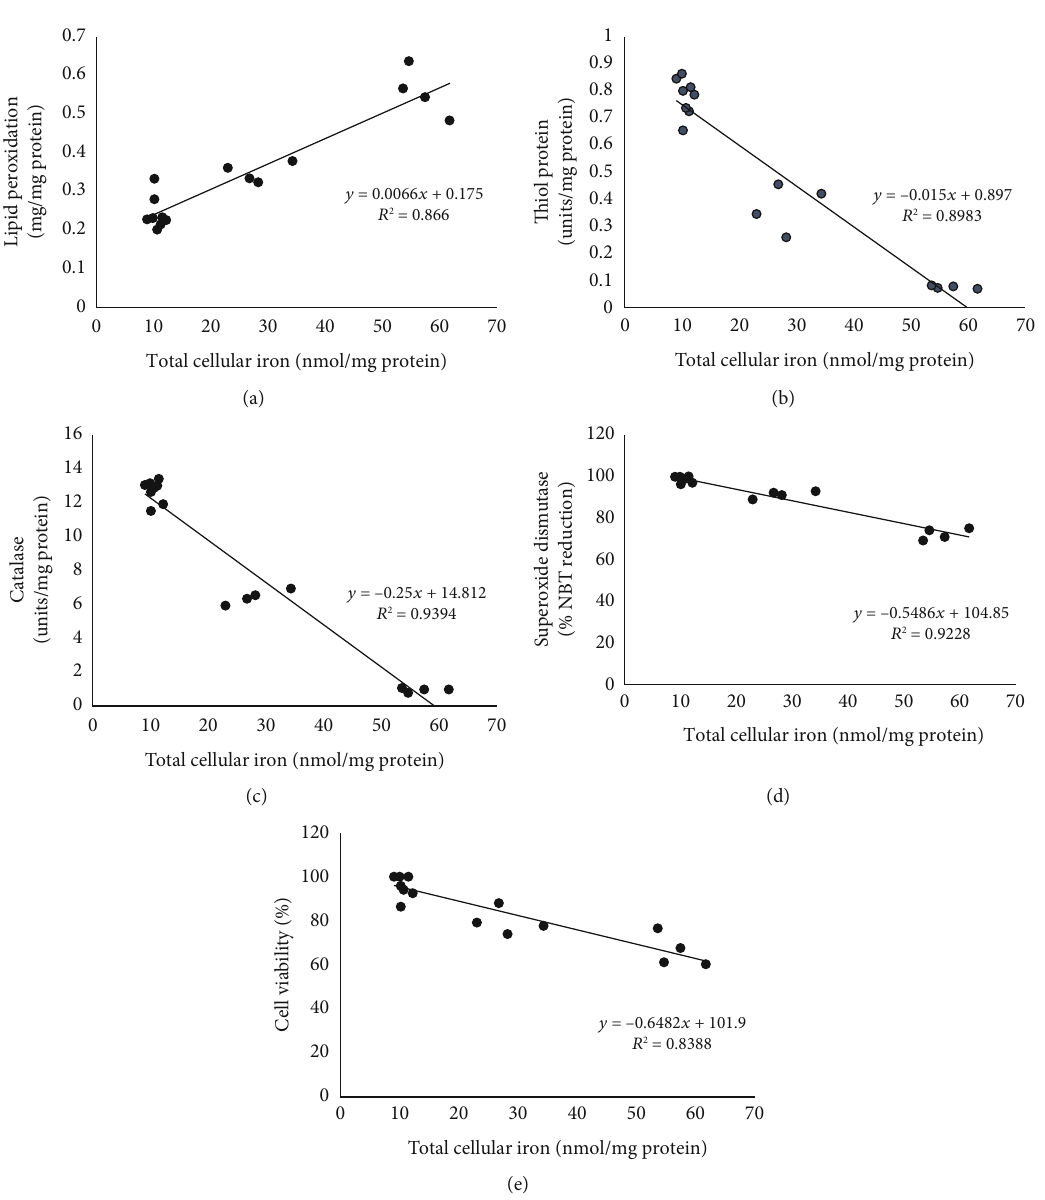
Figure 7: Scatter plot depicting the correlation between total cellular iron, oxidative stress, and cell viability in cells treated with iohexol: (a) lipid peroxidation, (b) thiol protein, (c) catalase, (d) superoxide dismutase activity, and (e) cell viability. NBT: nitroblue